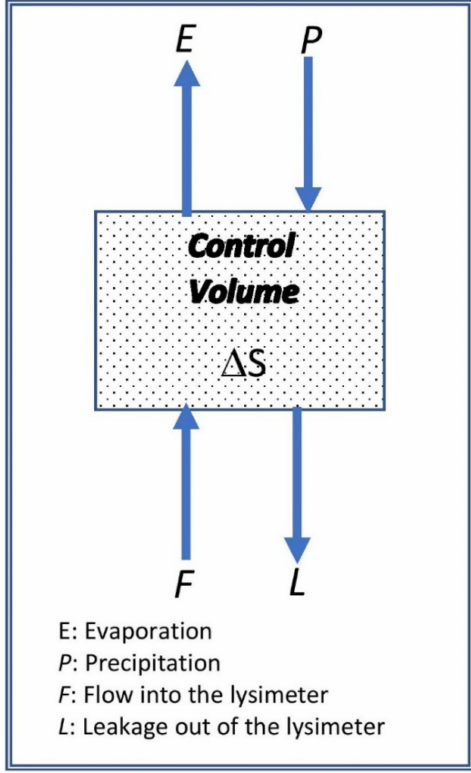
Figure 3. Control volume representing a